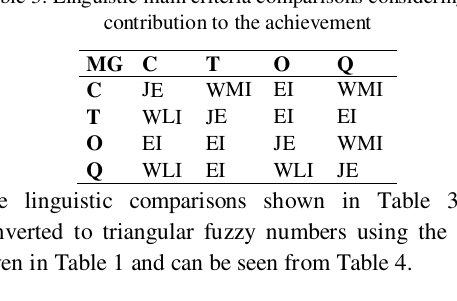
Table 4. Main criteria comparisons considering the